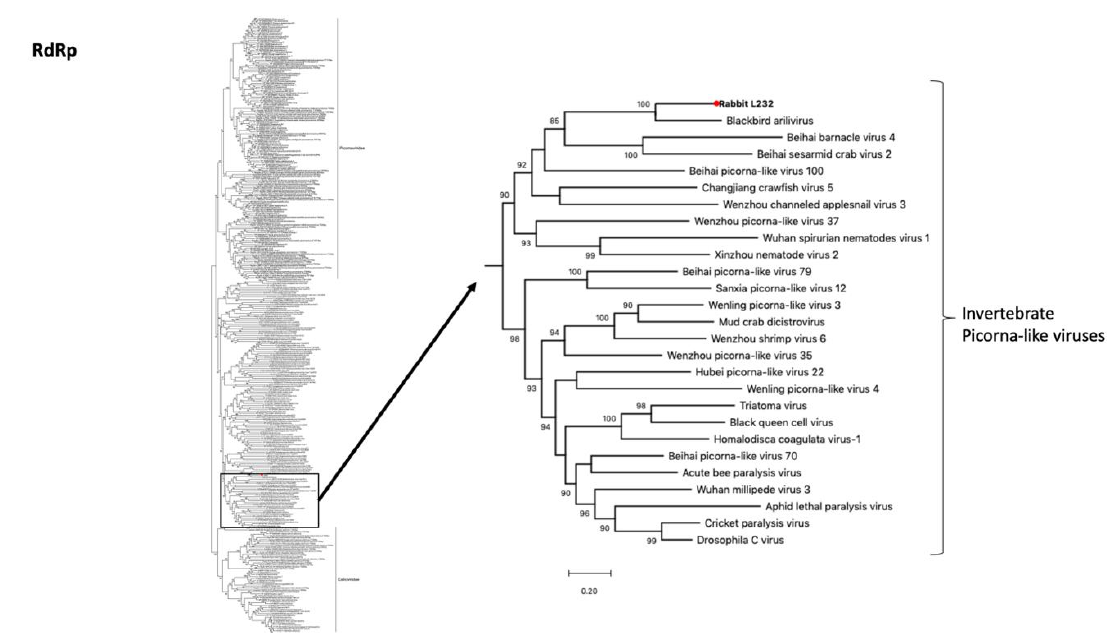
Figure 6. Phylogenetic relationships of the novel rabbit picorna-like virus based on analyses of the RdRp gene. Maximum likelihood phylogenetic analysis of picornavirus partial RdRp gene sequences, revealing that the rabbit picorna-like virus falls within a clade of invertebrate picorna-like viruses. The novel sequence obtained from the French rabbit L232 was analyzed alongside reference sequences representing different picorna-like viruses. Branch lengths are drawn to a scale of amino acid substitutions per site. Numbers above individual branches indicate the bootstrap support; only values >80% are shown. The novel rabbit L232 associated picorna-like virus is marked with a red dot.